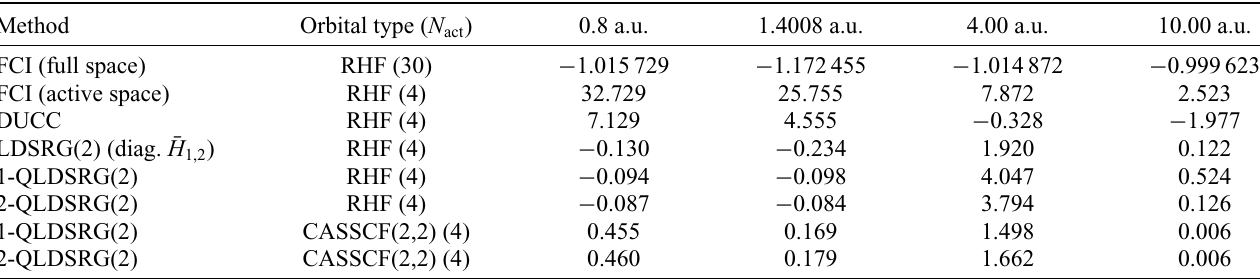
TABLE VII. A comparison of the energy errors (in m E h ) of the QDSRG and the DUCC for the H 2 molecule at four bond lengths in . The size of the active space is denoted in parentheses. The energy errors the cc-pVTZ basis, using DSRG flow parameter s = 0.5 E − 2 h are with respect to the full-space (30-orbital) FCI computations [absolute energies (in E h ) are shown in the first row]. The DUCC data are taken from Ref. [47].